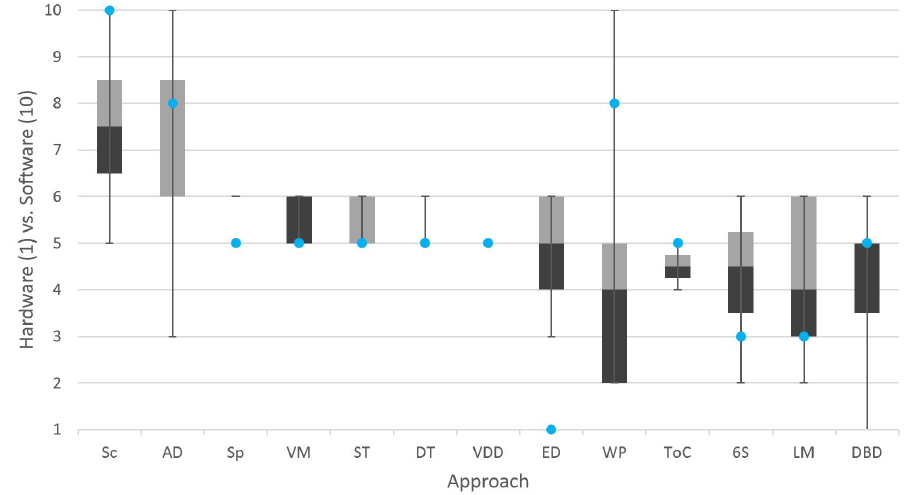
Figure 9. Perceived approach suitability to hardware vs. software. Shaded boxes span the interquartile range, separated by the median. Error bars represent upper and lower extremes. Blue dots represent the authors’ initial classification. Approaches ordered by decreasing